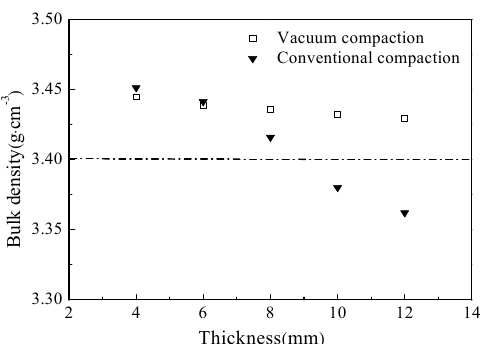
Figure 2. The bulk density of as-prepared samples, pressed by vacuum compaction and conventional compactions, with respect to thicknesses.